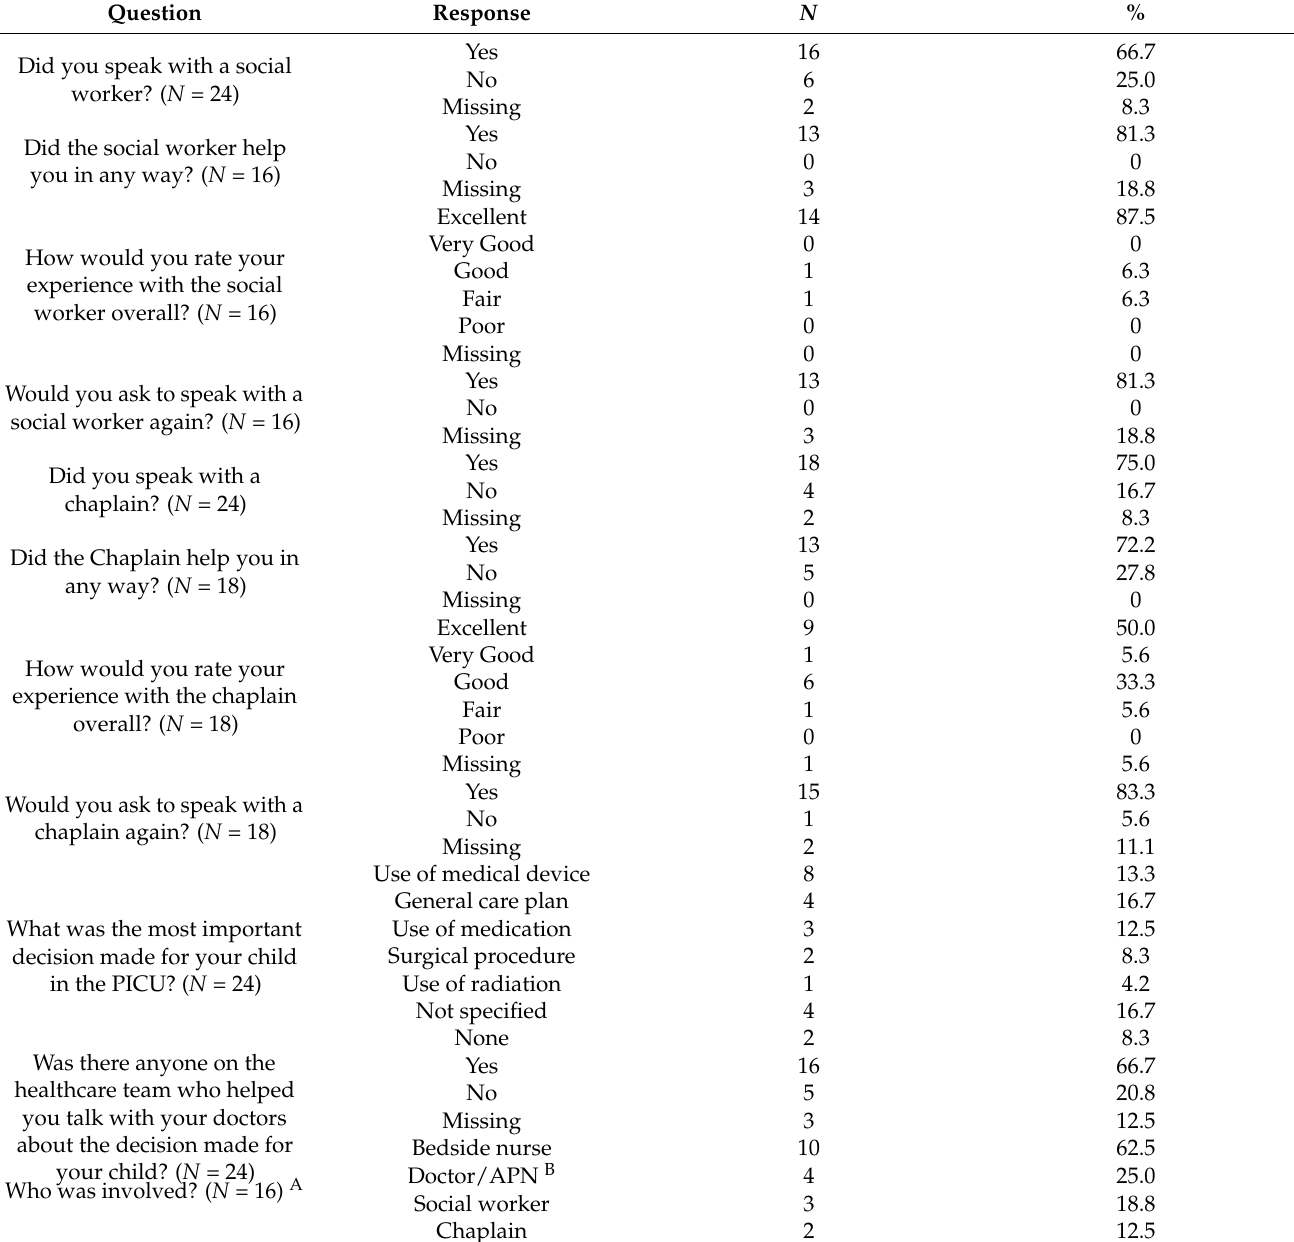
Table 3. Parent survey